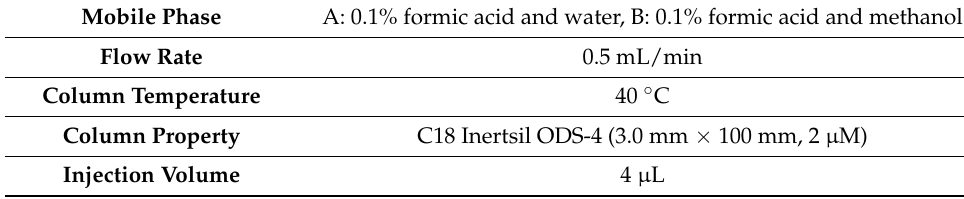
Table 5. The working method of